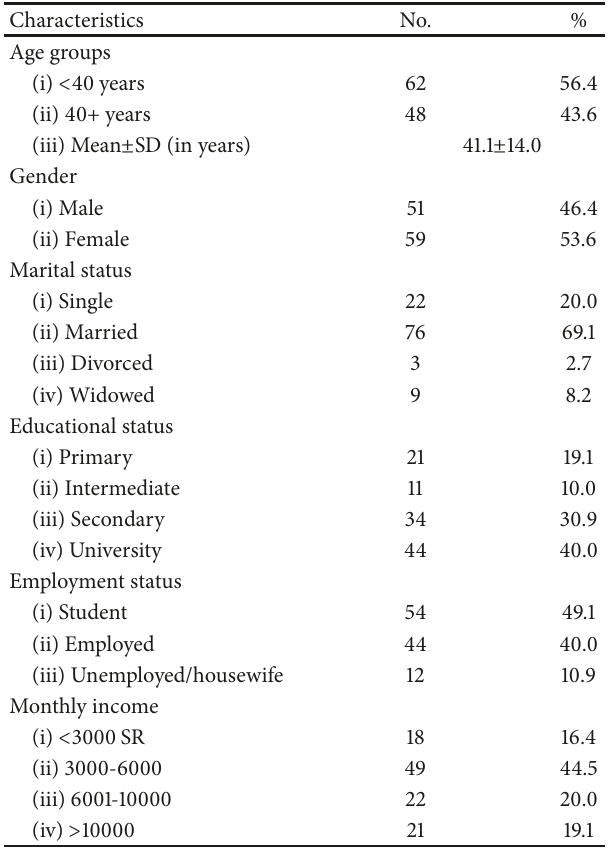
Table 1: Personal characteristics of study sample.